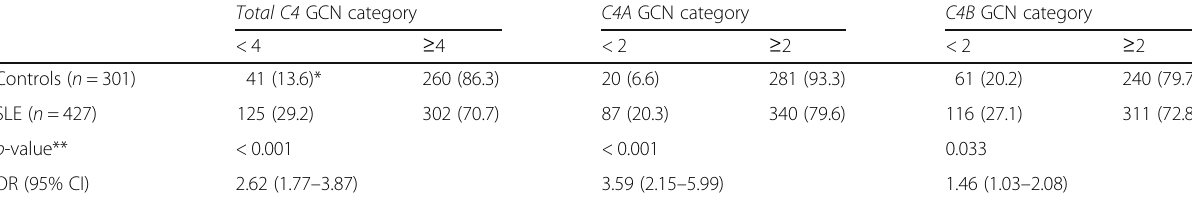
Table 4 Low gene copy number (GCN) for total C4 , C4A and C4B genes is associated with systemic lupus erythematosus